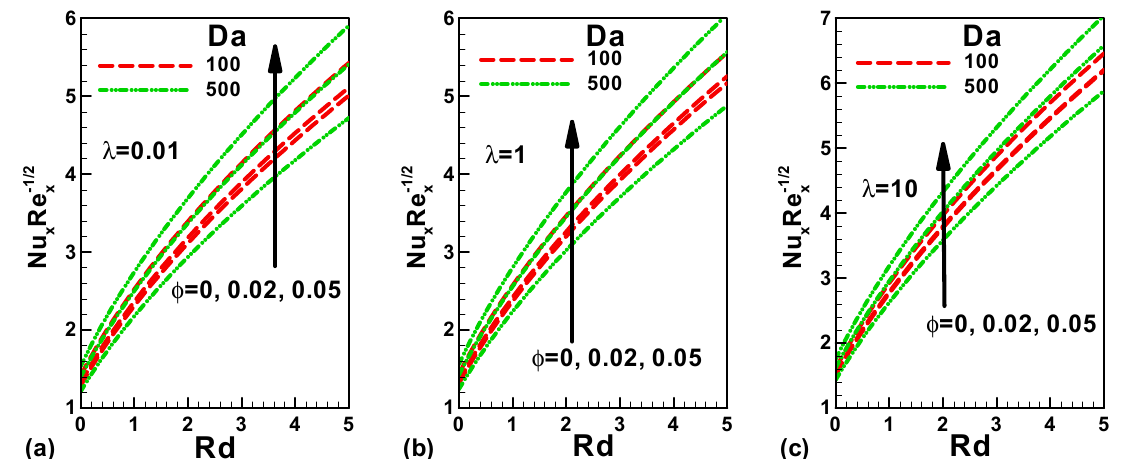
Figure 11. Variation of skin friction with Rd , Da and ϕ for ( a ) forced convection, ( b ) mixed convection, and ( c ) free convection. [ n =0.5, Ω = π /6, K = 2, m = 1].